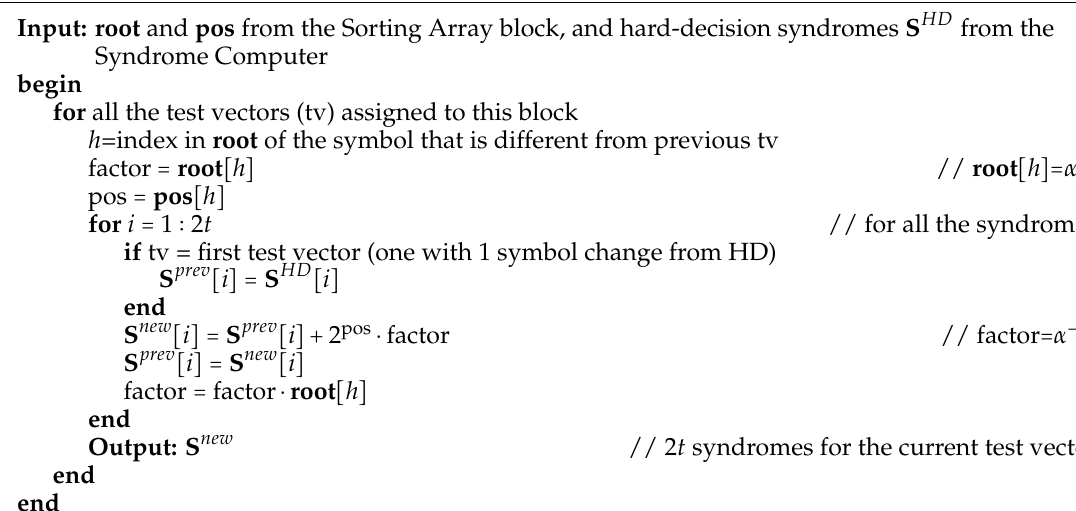
Algorithm 2 Pseudocode for the Syndrome Update